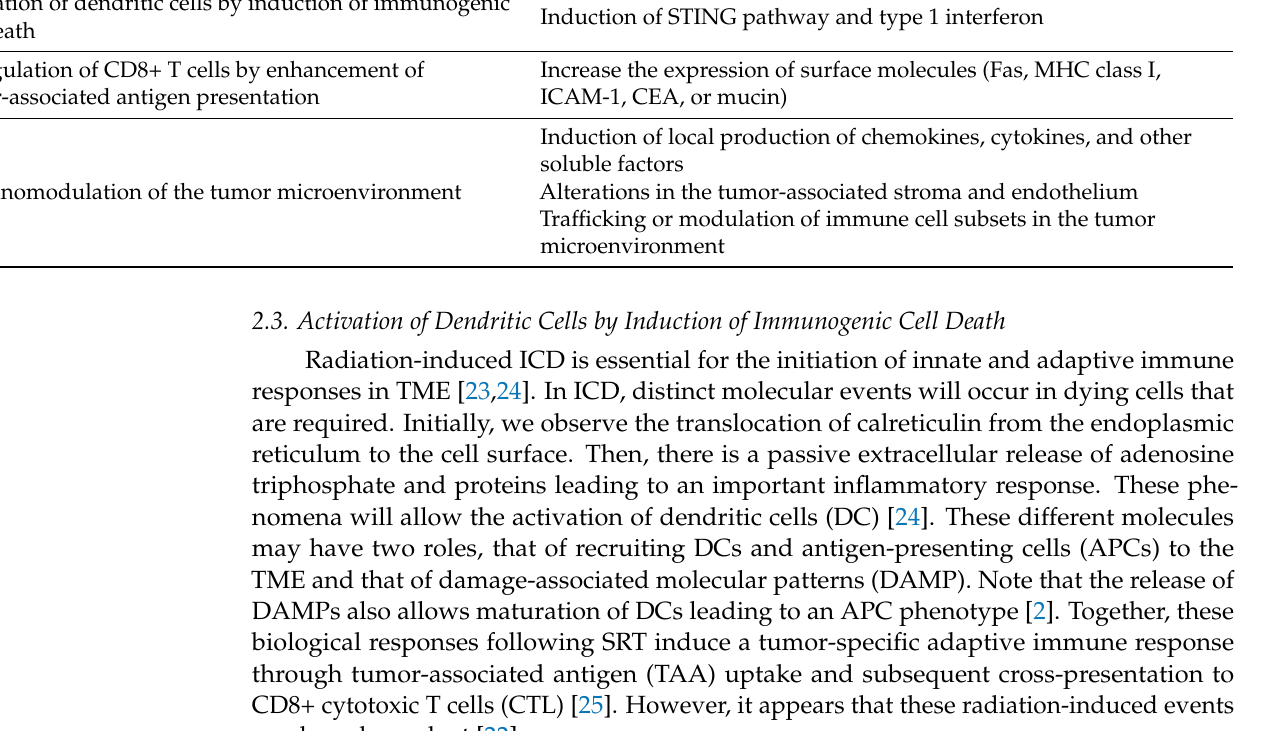
Table 1. Main mechanisms of immuno-modulation by stereotactic radiation therapy. Steps of Action Mechanism of Stereotactic Radiation Therapy Activation of dendritic cells by induction of immunogenic Induction of STING pathway and type 1 cell death